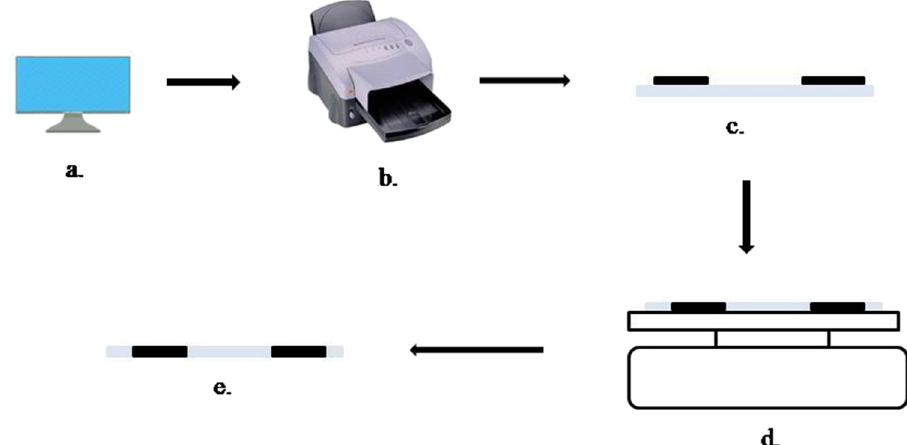
Figure 2: Technique for wax printing of PADs: ( a ) computer for designing the pattern, ( b ) wax printer for printing the pattern, ( c ) paper printed with wax ink, ( d ) paper being heated on hot plate for melting wax to make complete hydrophobic barriers, and ( e ) properly fabricated PAD by wax printing